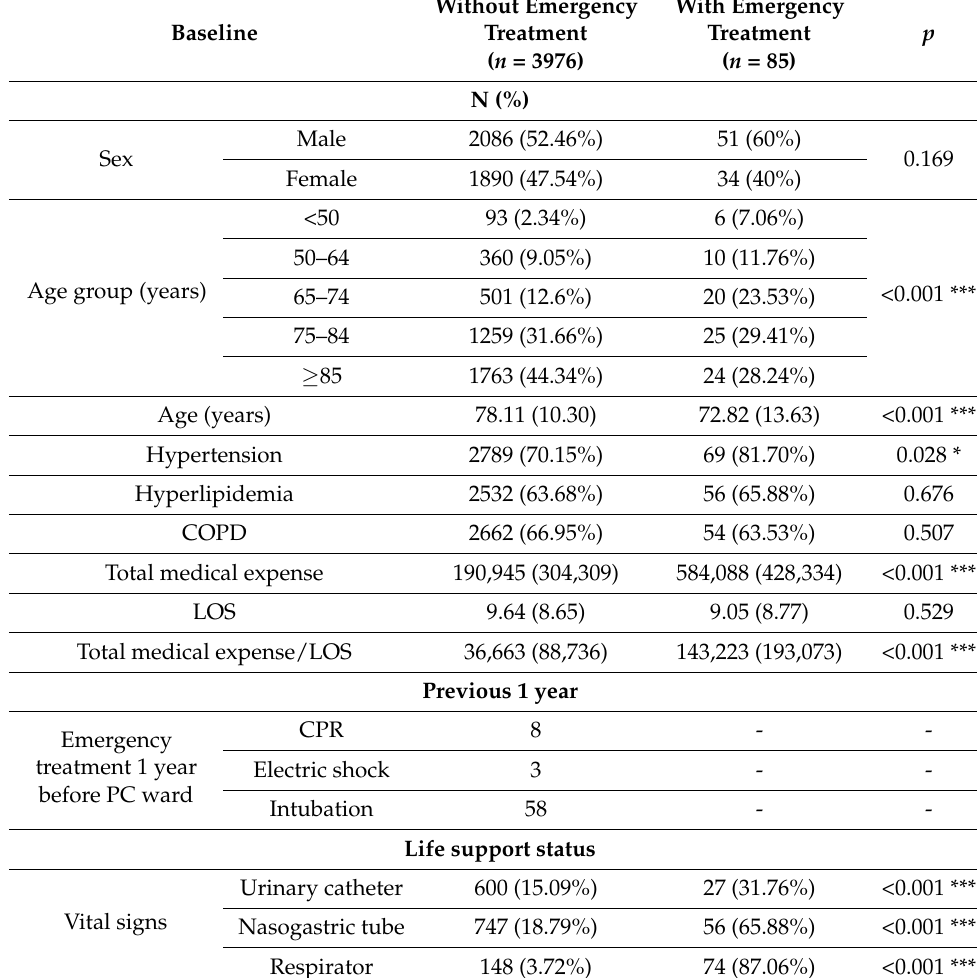
Table 2. Inpatients at end of life with and without emergency